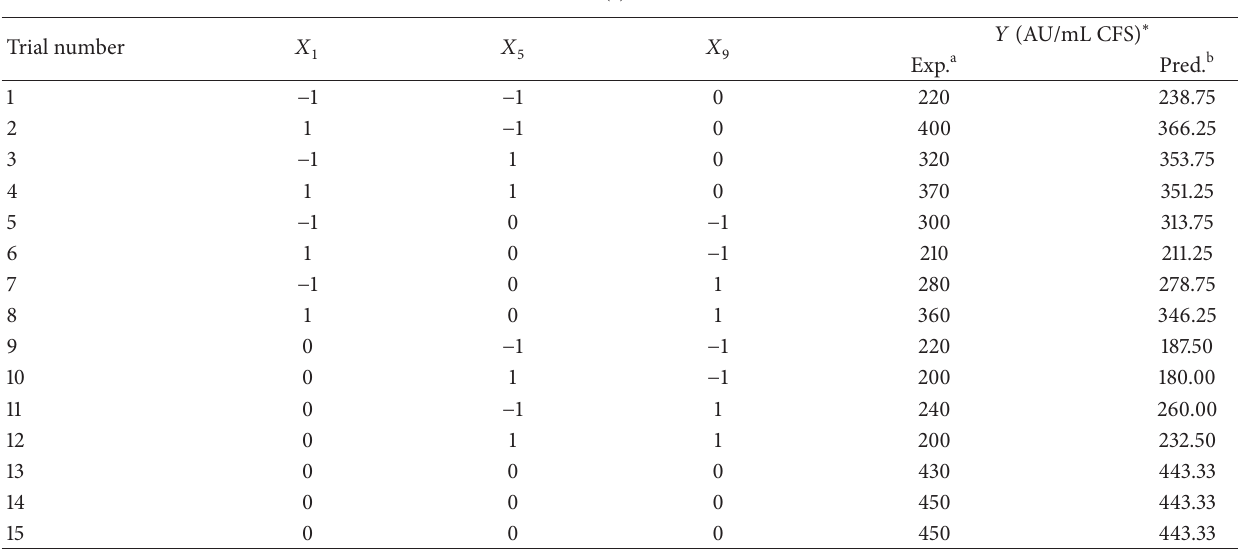
Table 4: (a) BBD with coded levels of three independent variables and experimental versus predicted BAC YAS 1 levels. (b) Real-coded values of independent variables and regression analysis for BAC YAS 1 optimization by BBD.